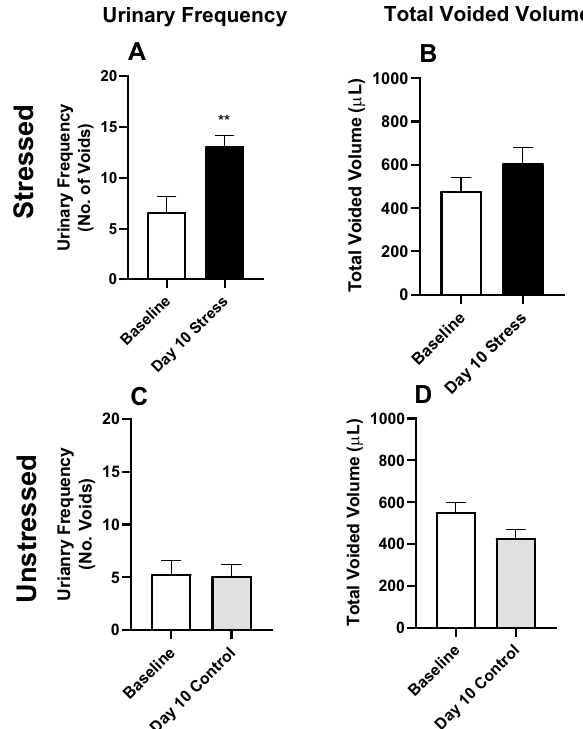
Figure 1. Urinary frequency (number of spots) and total urine volume (μl) at baseline (day 0) and after 10 days of WAS ( A , B ) or normal housing ( C , D ) in female mice. Data represented as mean ± SEM (n = 7) and analysed by paired Students t test (**p < 0.01 vs